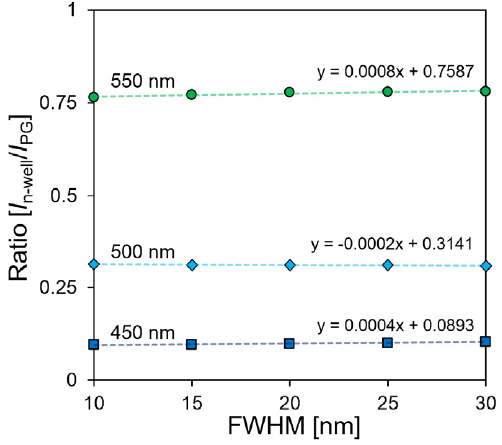
Figure 7. FWHM dependence of current ratio.